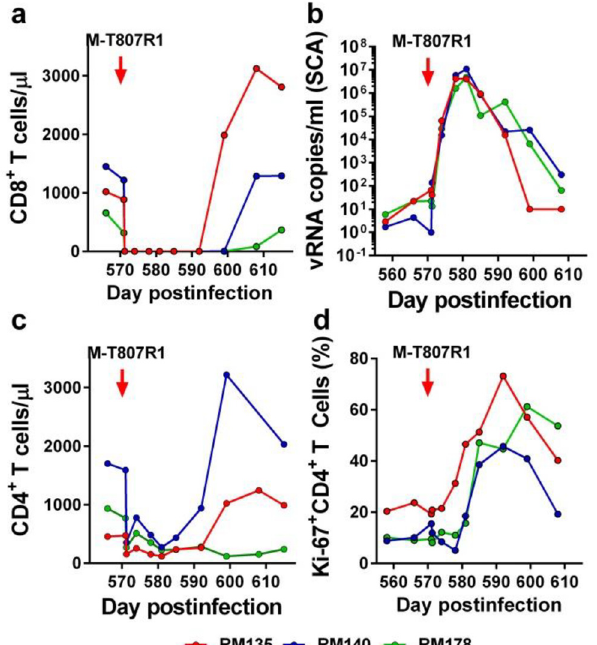
Fig 11. Experimental ablation of CTL responses through experimental CD8 + cell depletion (with the M-T807R1 anti-CD8 monoclonal antibody) result in patterns of viral rebound and immune activation that are different from those observed after RMD administration. Changes in the levels of (a) CD8 + T cells; (b) PVLs; (c) CD4 + T cells; and (d) CD4 + T cell proliferation (Ki-67) after administration of the M-T807R1 monoclonal antibody. Times of M-T07R1 administration are depicted as a red